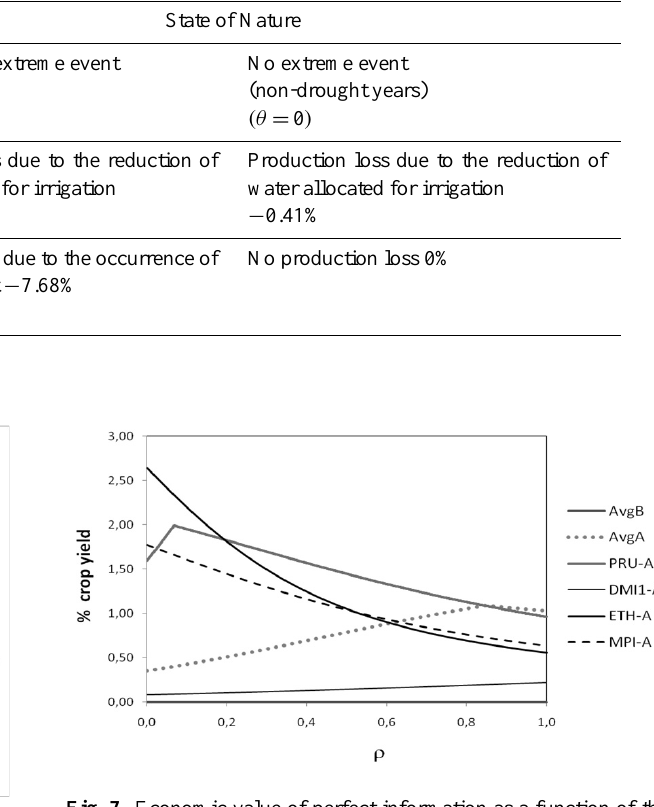
Fig. 6. Optimal policy regions.